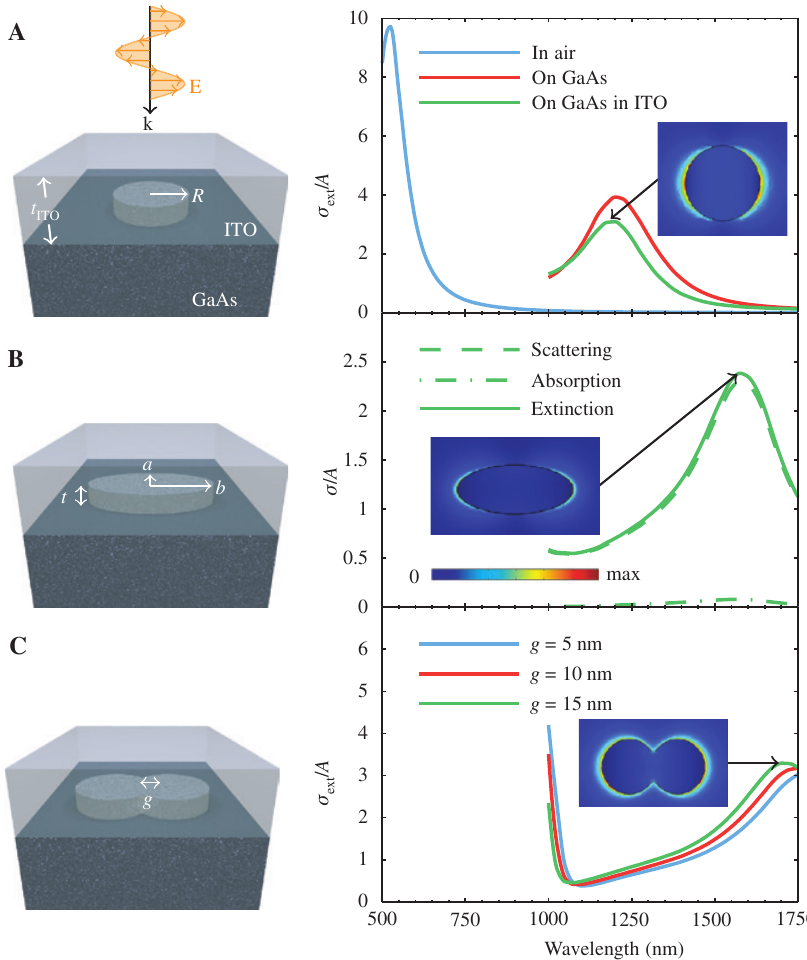
Figure 4: Resonance behavior of three characteristic shapes of silver NPs. (A) Left: Schematic illustration of the simulation model depicting a TM plane wave impinging normal to the circular silver nanodisk